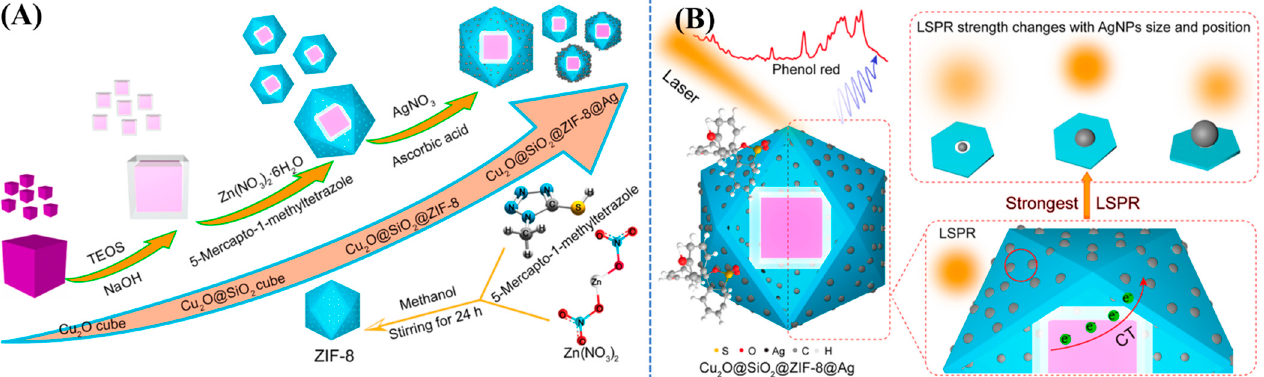
Figure 11. ( A ) Schematic diagram of the fabrication process of unique MOFs’ structure as Cu 2 O@SiO 2 @ZIF-8@Ag. ( B ) Mechanism of Raman detection of phenol red using MOFs templates based on Cu 2 O@SiO 2 @ZIF-8@Ag. Adapted from [36].